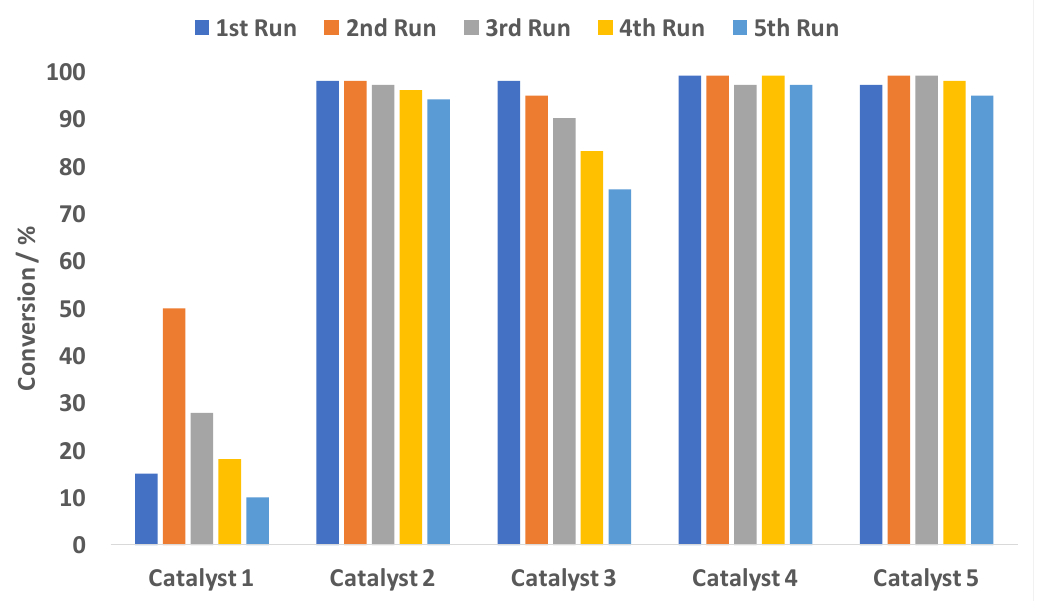
Figure 6. The Suzuki coupling of 4 ‐ bromotoluene with phenylboronic acid (after 30 min) using 0.5 mol % Pd. Catalyst 1: Ce 0.99 Pd 0.01 O 2 ‐δ , Catalyst 2: Ce 0.79 Sn 0.2 Pd 0.01 O 2 ‐δ , Catalyst 3: Ce 0.495 Sn 0.495 Pd 0.01 O 2 ‐δ , Catalyst 4: Ce 0.20 Sn 0.79 Pd 0.01 O 2 ‐δ , and Catalyst 5: Sn 0.99 Pd 0.01 O 2 ‐δ [53] (Adapted with permission from Elsevier).